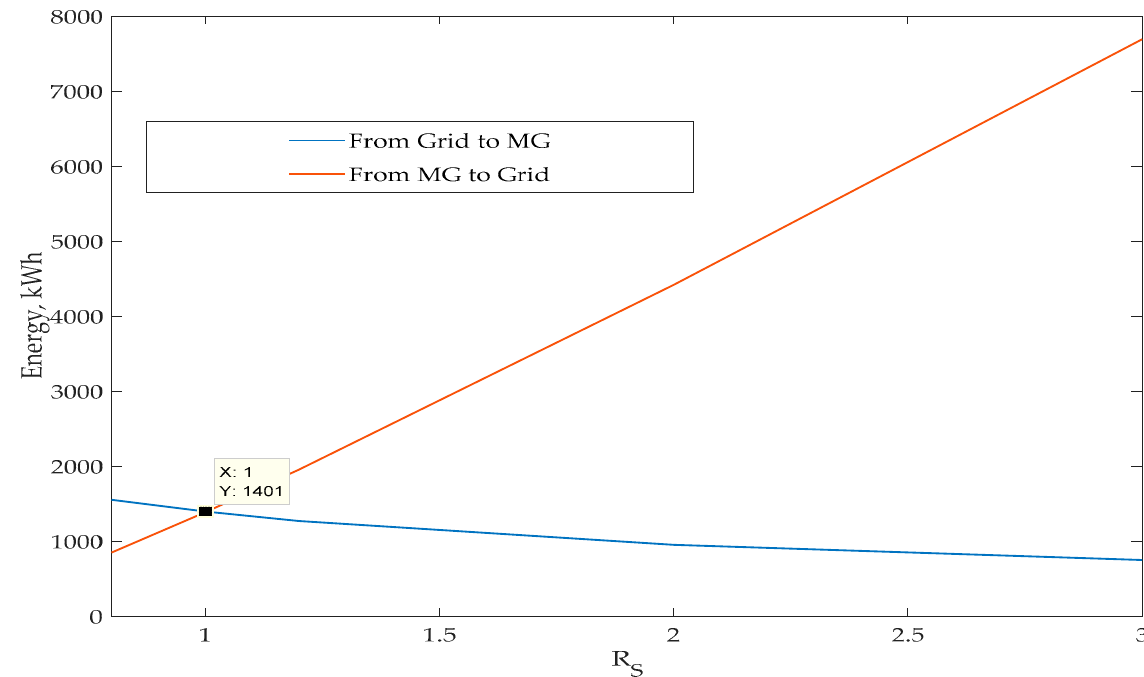
Figure 5. Dependence of energy flows between the utility grid (UG) and microgrid (MG) without buffer battery (BB) for different R S values.